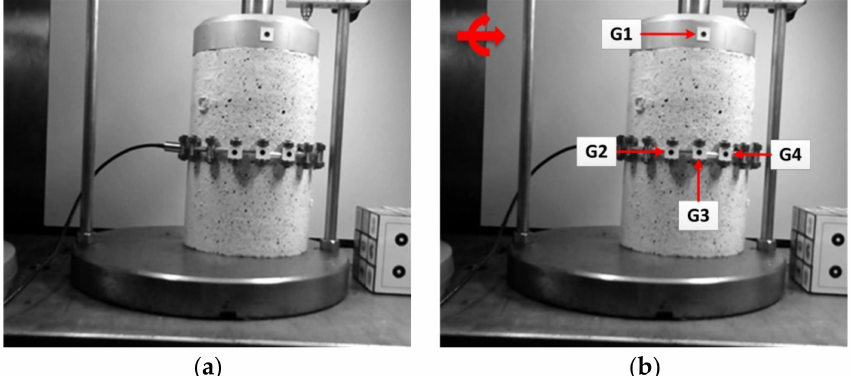
Figure 4. Image data preparation: ( a ) main captured image; ( b ) synthetically moved